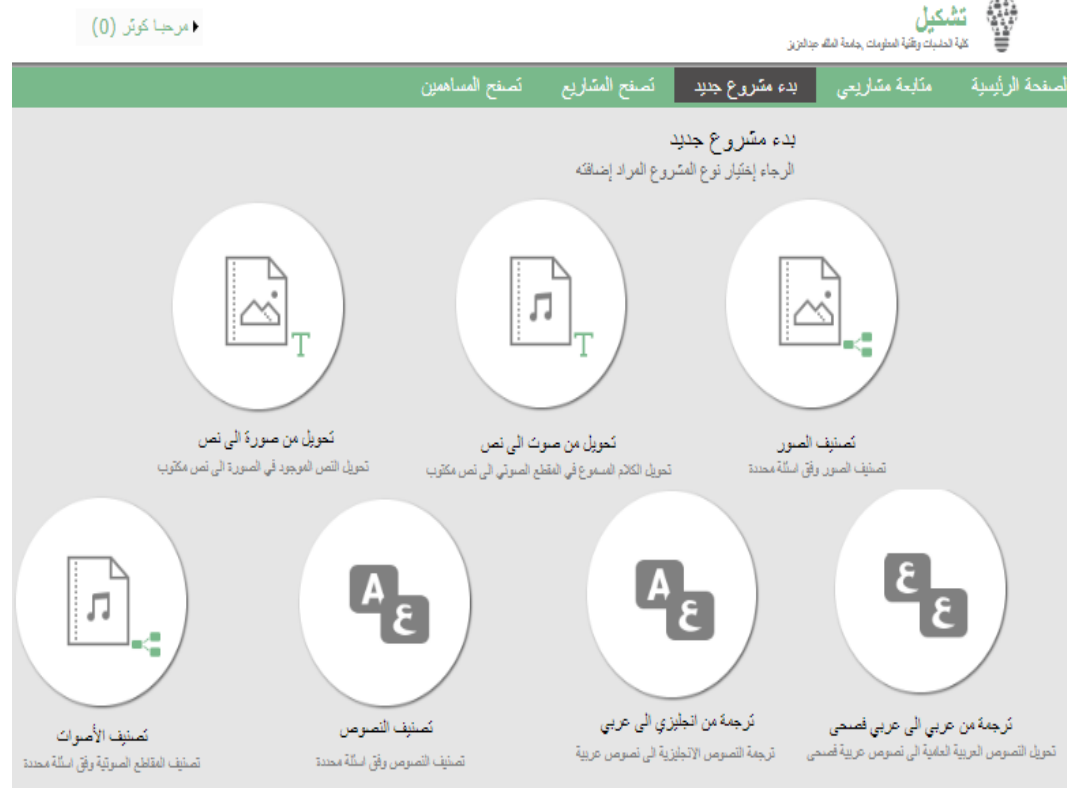
Figure 3. Tashkeel natural language processing (NLP) project types (this figure shows seven types of NLP projects, as described in point 1 to 7 in the previous paragraph).